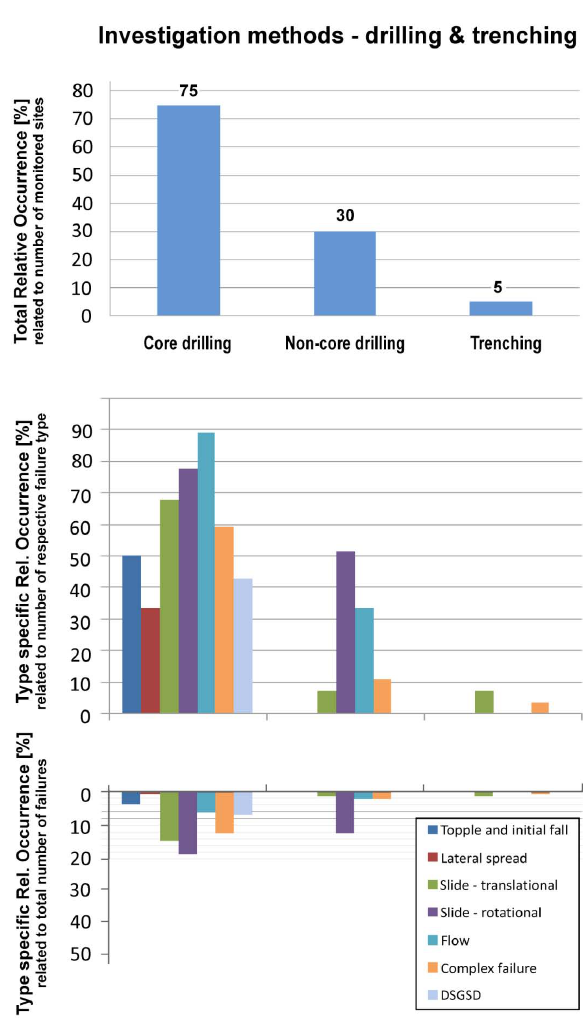
Fig. 5. Review of total relative occurrence and type-specific rela- tive occurrence of drilling and trenching approaches applied in the monitored landslide sites.